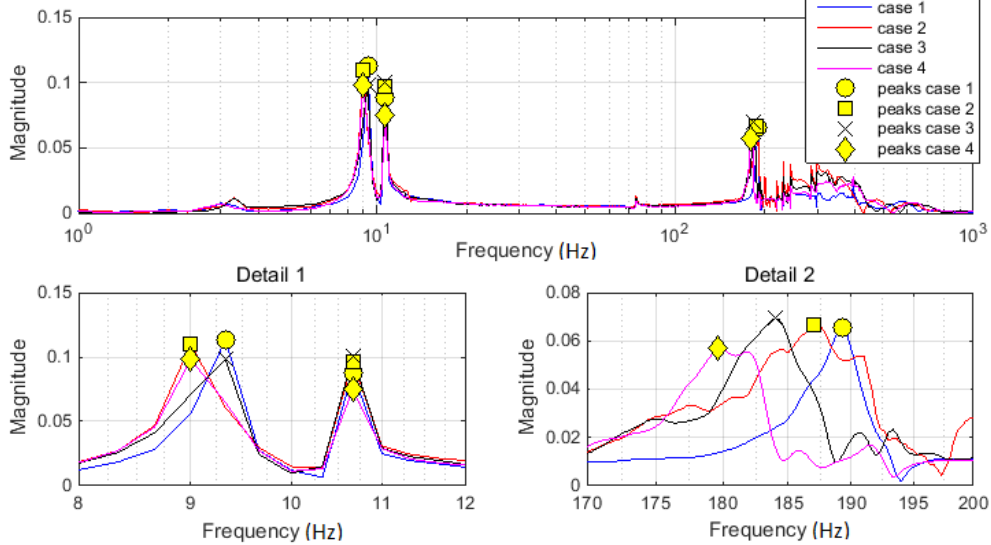
Figure 8. FFT magnitude of mass accelerations with marked significant peaks (in frequency range of interest). The first detail diagram focuses on the frequency range around 10 Hz. The second detail diagram focuses on the frequency range around 185 Hz. Markers and colors are explicated in the legend.